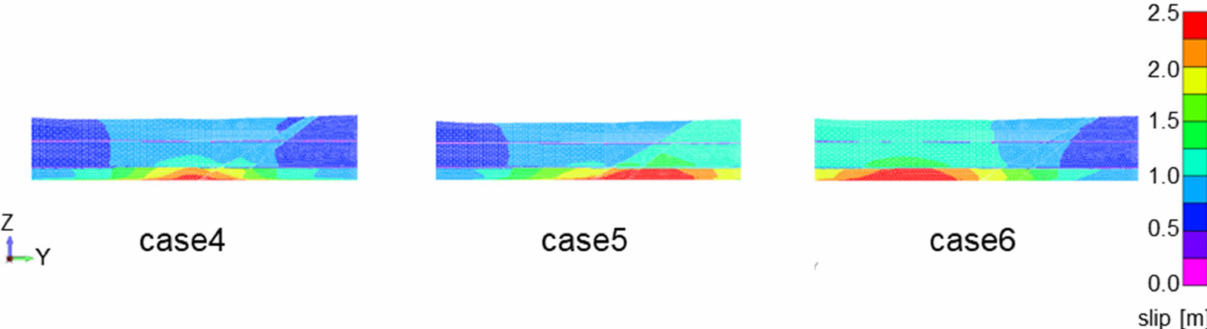
Figure 18. Surface slip–input slip relationship (case4 to case6).